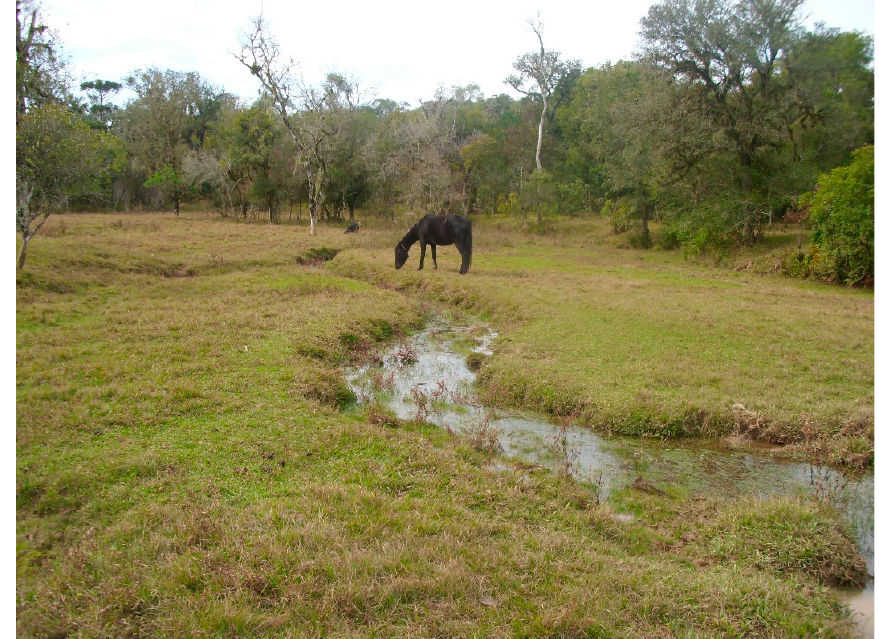
Figure 7. Illustrative picture of a permanent stream used for livestock consumption in a faxinal farm of the municipality of Prudentópolis. Author: Valdemir Antoneli.